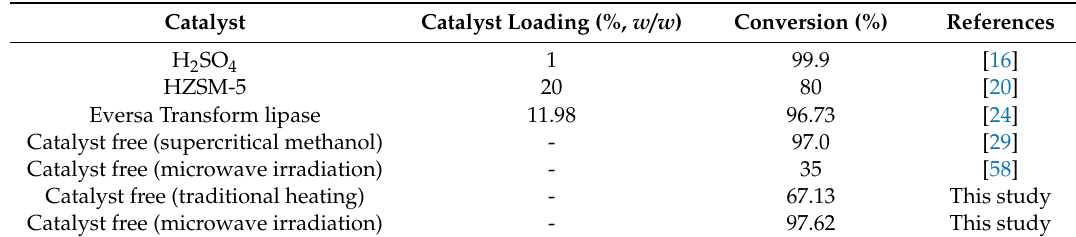
Table 4. Oleic acid esterification using di ff erent methods for producing biodiesel.